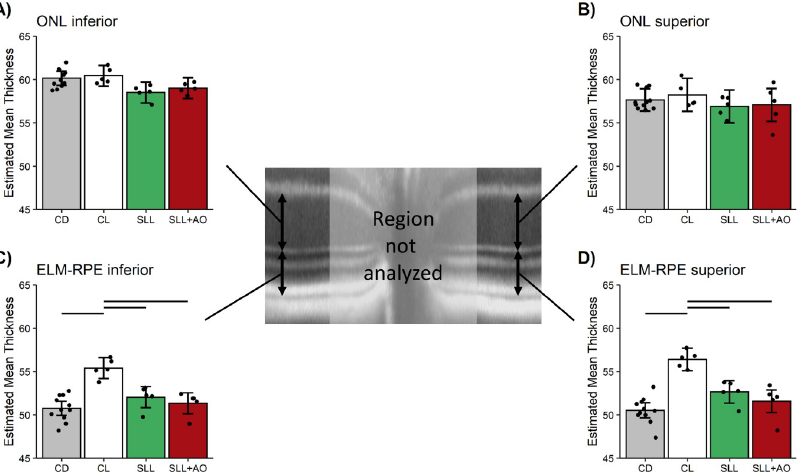
Fig 5. 1 hr post-sildenafil after 4 hr of light-adaption mice (SLL, Fig 2) shows thinner, dark-like ELM-RPE. Modeled A) ONL inferior retina, B) ONL superior retina, C) ELM-RPE thickness inferior retina, and D) ELM-RPE thickness superior retina in uninjected control dark (CD, n = 11 mice, grey bar), control light (CL, n = 5 mice, white bar), SLL+saline (SLL, n = 5 mice, green bar), and SLL+AO (n = 5 mice, red bar) in the two different retinal regions. ONL is invariant to condition. ELM-RPE is significantly (horizontal black bar) thinner in the dark than in the light (CD vs. CL) as expected [44, 53, 54]. In SLL+saline and SLL+AO groups ELM-RPE thickness is not different from CD (and was thinner than CL); no evidence for oxidative stress was found. The points in each plot represent the estimated mean for each mouse based on the model. Error bars indicate 95% confidence intervals. Note the same control data sets are presented in each graph to facilitate comparisons.